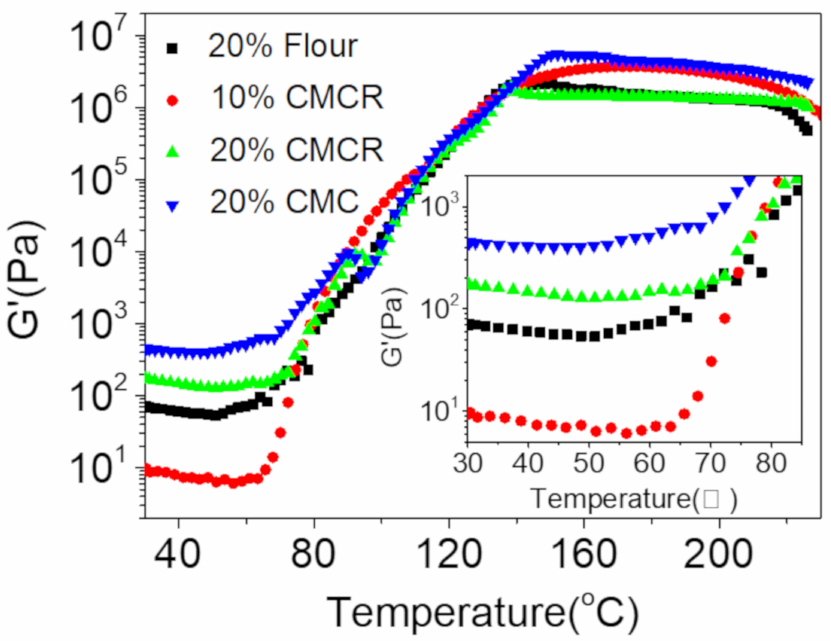
Figure 6. Variable temperature rheology analysis of UF resins with di ff erent fillers; 10% CMCR represents that the mass percentage of filler was